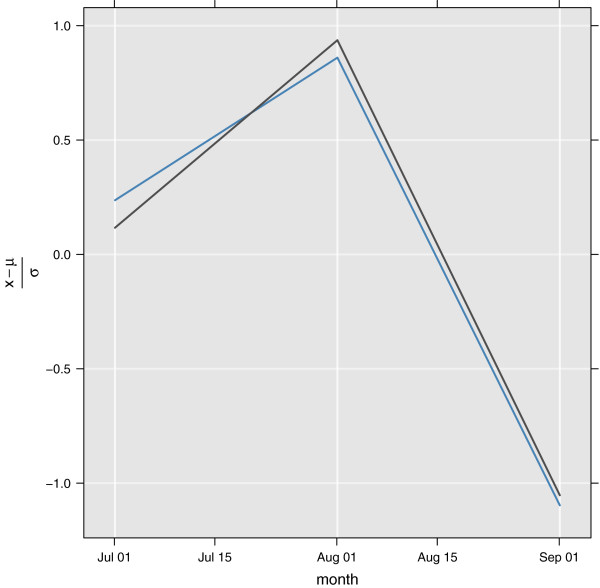
Scaled variations over time of An. arabiensis  larva in Zwai, Ethiopia (YE2003). Observed (grey solid line), and model (solid blue line).